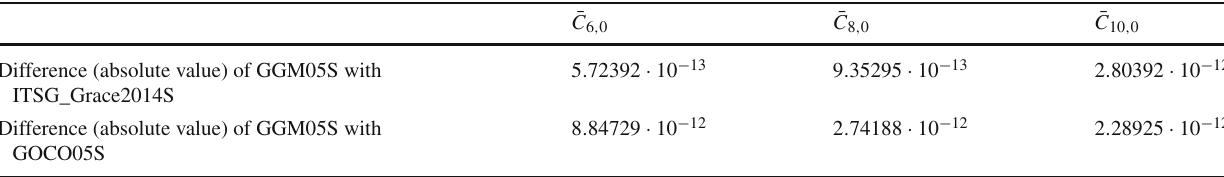
Table 1 Difference of the even zonal harmonics ¯ C 6 , 0 , ¯ C 8 , 0 and ¯ C 10 , 0 of GGM05S with those of ITSG_Grace2014S and GOCO05S